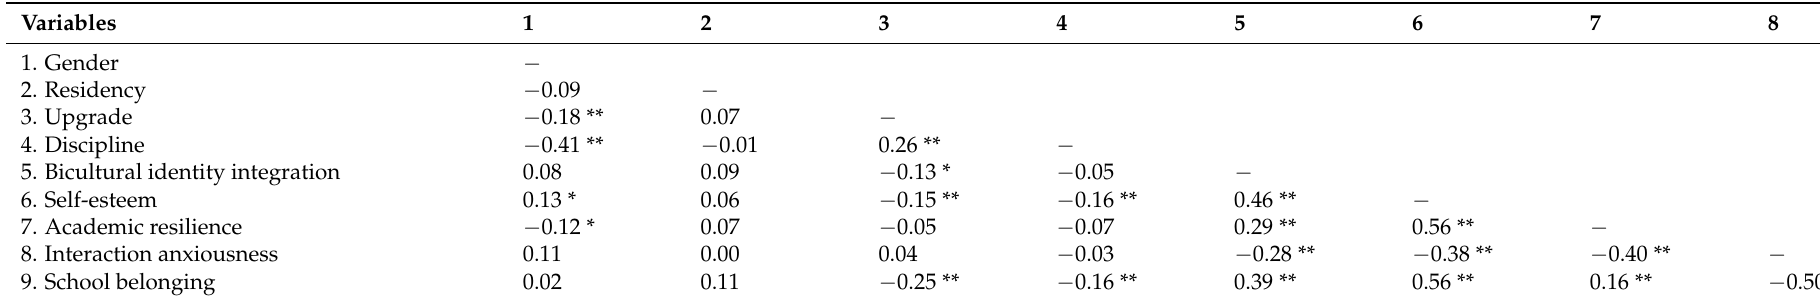
Table 3. Correlations of the